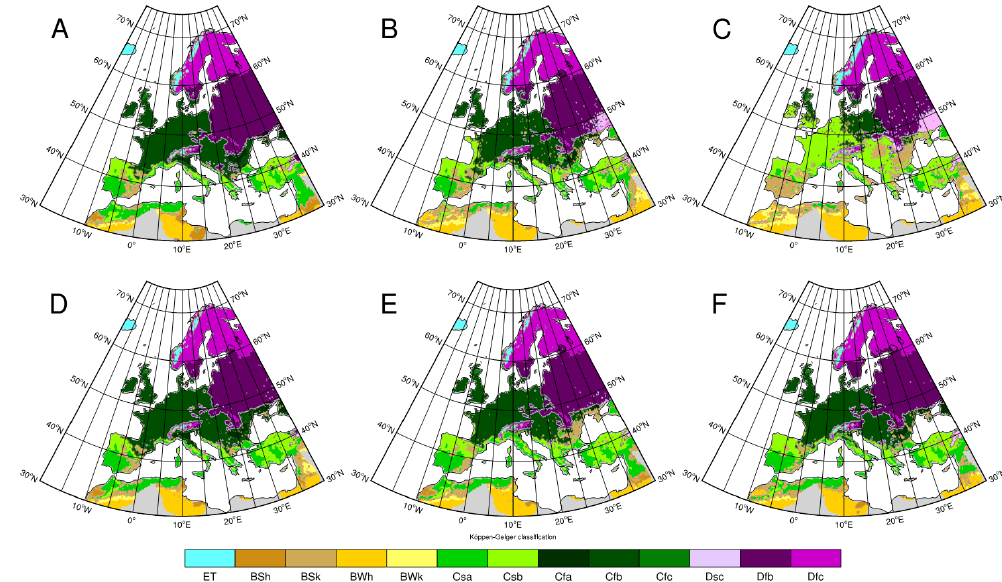
Figure 4. Simulated K-G climate classification according to E-OBS ( A ) and quantile mapping of precipitation and temperature based on a gamma + Generalized Pareto Distribution (gpQM) correction of precipitation and eQM correction of temperature with 90-day moving window in ALADIN ( B ), HIRHAM ( C ), RegCM ( D ), RAMCMO2 ( E ) and RCA ( F ).